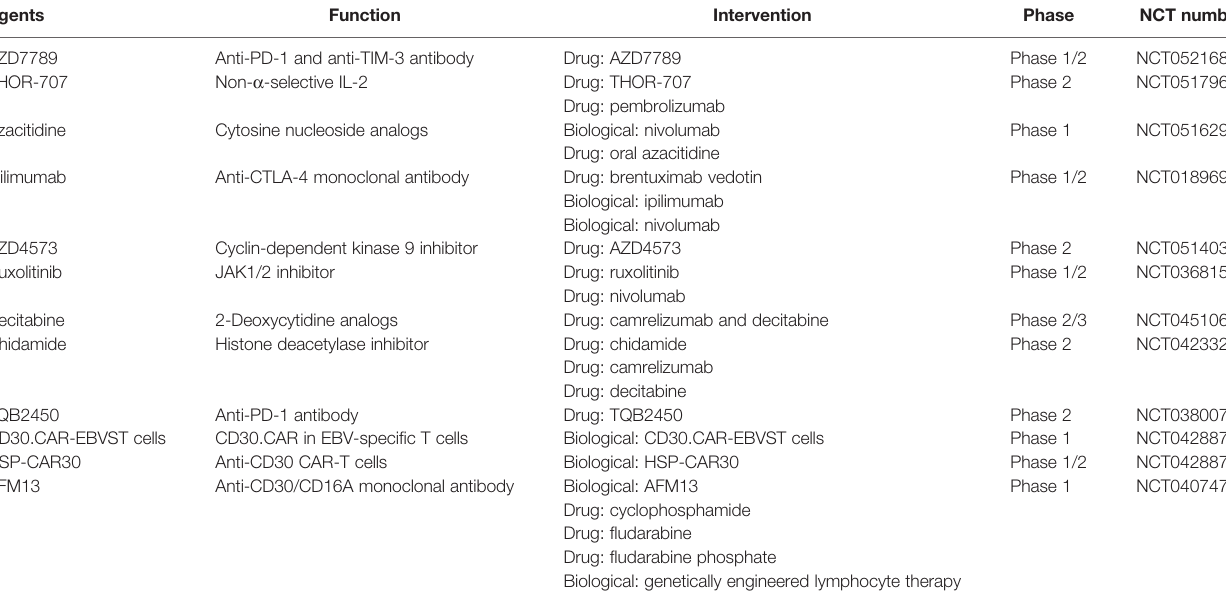
TABLE 3 | Clinical trials of novel agents in the treatment of r/r cHL under